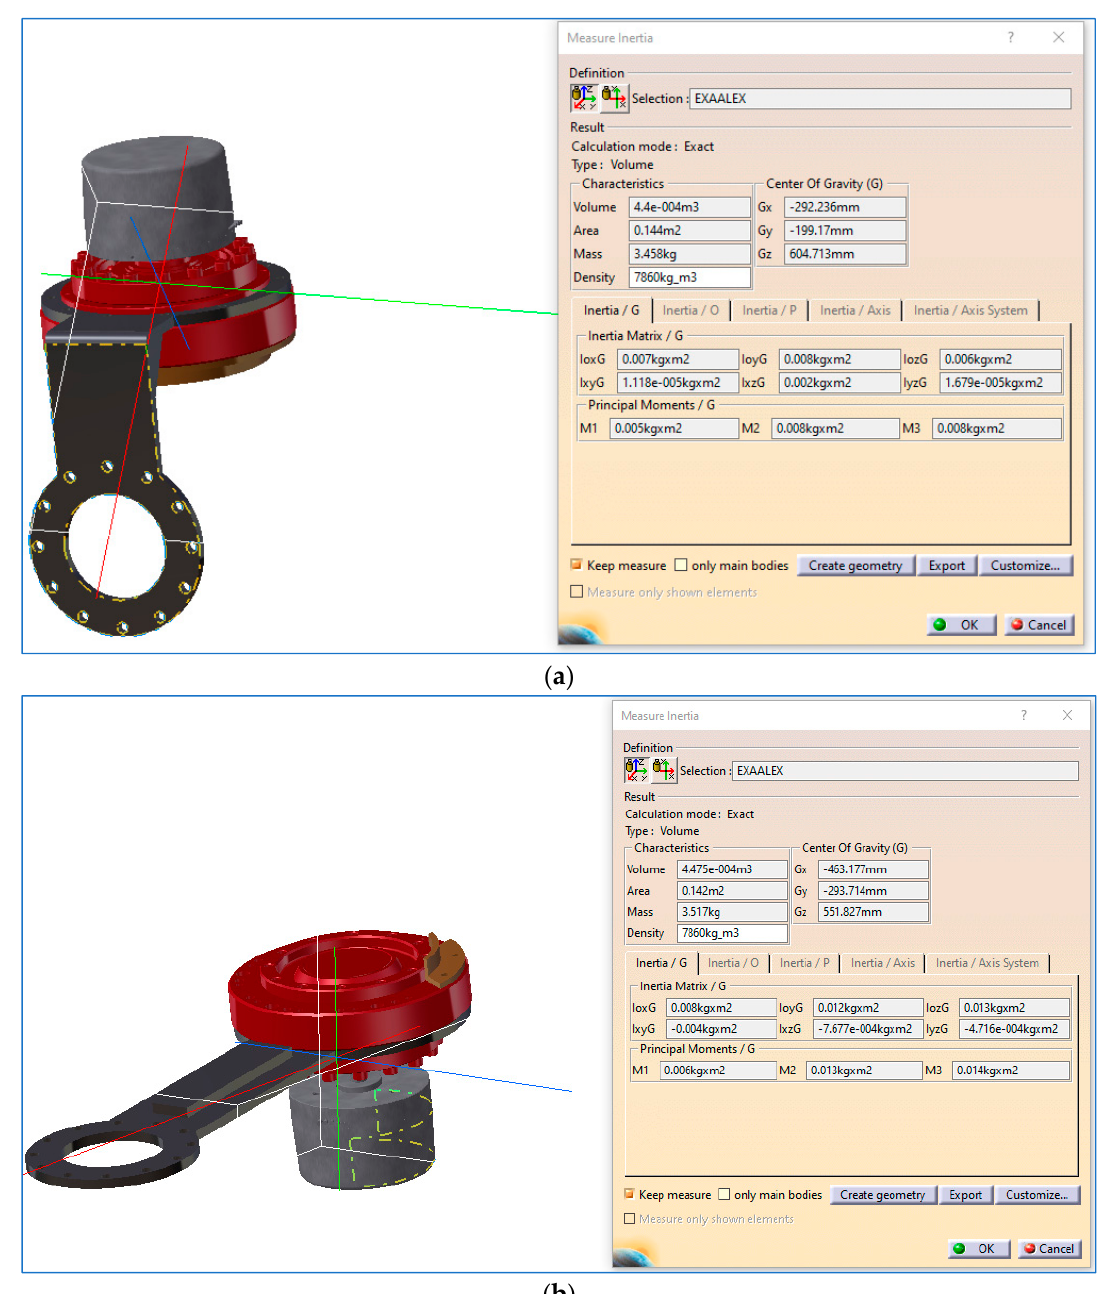
Figure 5. Joints 2 and 3 of the CardioVR-ReTone exoskeleton mass parameters. ( a ) Mass properties—Joint 2; ( b ) mass properties—Joint 3. (Catia software capture)